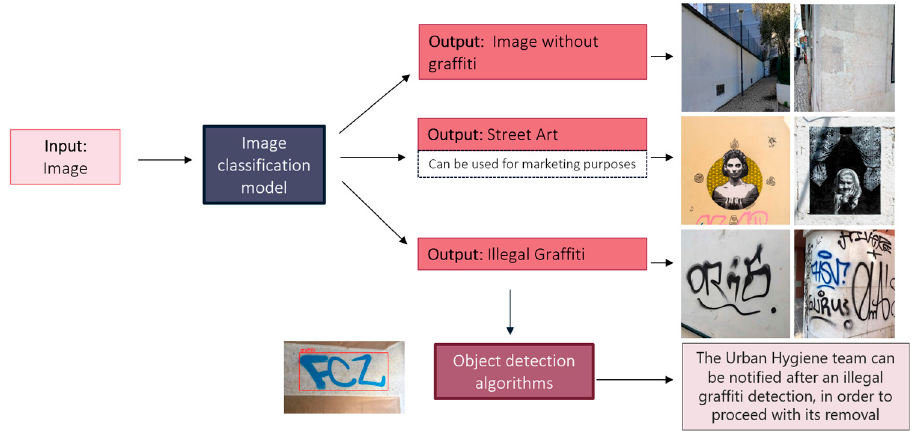
Figure 5. Summary of the implemented system.